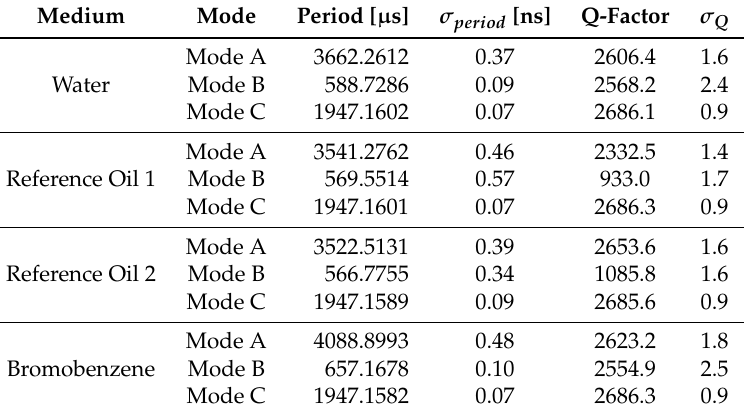
Table 2. Measurement data for different